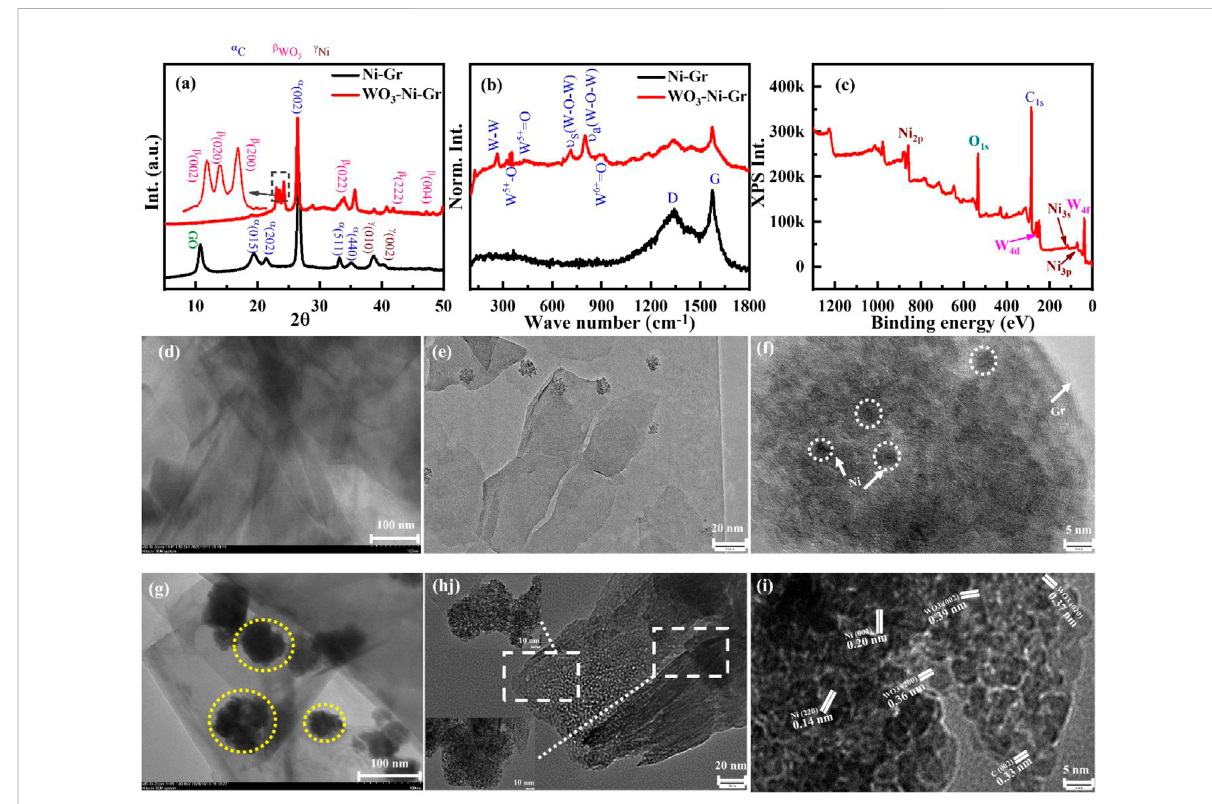
FIGURE 3 (A) XRD patterns of Ni-Gr (bottom) and WO 3 -Ni-Gr (top) composites. Characteristic diffraction peak C (002) at 26.4 ° represent the graphitic natureofGr.MinutediffractionpeaksofNi(010)andNi(002)showthattheNi-Grcompositesareformed.23.0 ° ,23.5 ° ,and24.3 ° whichcorrespondto (002), (020), and (200) re fl ection of WO 3 highlighted by the inset con fi rmed that WO 3 nanostructures were successfully modi fi ed on the Ni-Gr composite. (B) TheRamanspectraofNi-Gr(bottom)andWO 3 -Ni-Gr(top)composites.GandDbandswerepresentforNi-Grcomposites.WO 3 functionalization in the WO 3 -Ni-Gr composite was con fi rmed by the emergence of new Raman modes of WO 3 at 240 cm − 1 , 335 cm − 1 , 431 cm − 1 , 805 cm − 1 , and 950 cm − 1 . (C) XPS survey scan of the WO 3 -Ni-Gr composite discloses that only W (4f, 4d state), O (1s), C (1s), and Ni (2p, 3s, and 3p) were present. (D) TEM images, (E,F) HRTEM image of Ni-Gr composites. Layered structures of Gr with dark spots of Ni show the Ni-Gr composite formation. (G) TEM images of the WO 3 -Ni-Gr composite. The irregular dark portion highlighted by yellow circles is due to WO 3 nanostructures with an average size of 53 ± 23 nm. (H) HRTEM images of WO 3 -Ni-Gr composites at 20 nm resolution. The inset shows the HRTEM image at 10 nm resolution. (I) HRTEM images of WO 3 -Ni-Gr composites at 5 nm resolution. HRTEM images show that crystallographic planes of (002) Gr, (220) and (002) of Ni, and (002), (020), and (200) of WO 3 are present for the WO 3 -Ni-Gr